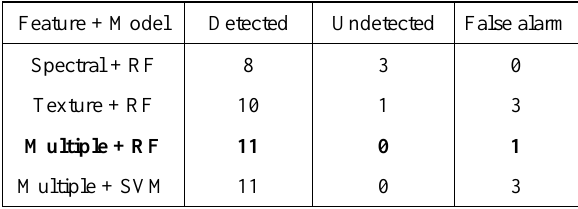
Table 2. Detection accuracy of different feature sets and models